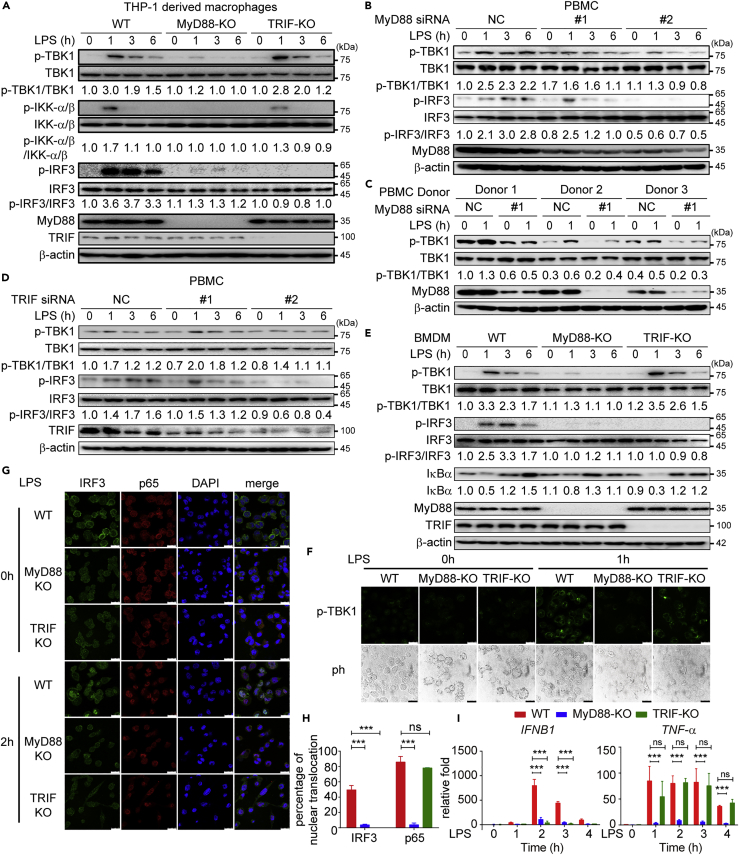
Both MyD88 and TRIF Are Critical for IRF3 Activation by LPS Treatment(A and B) Wild-type (WT), MyD88-knockout (KO), and TRIF-KO THP-1-derived macrophages (A) and peripheral blood mononuclear cells (PBMCs) transfected with or without MyD88 siRNA (B) were stimulated with LPS (200 ng/mL) for indicated time points. Phosphorylation of indicated proteins was detected by immunoblot (IB) analyses.(C) PBMCs from three different donors with or without MyD88 siRNA transfection were stimulated with 200 ng/mL LPS for 1 h or left untreated. Phosphorylation of TBK1 was detected by IB analysis.(D) PBMCs transfected with or without TRIF siRNA were stimulated with LPS (200 ng/mL) for indicated time points. Phosphorylation of indicated proteins was detected by IB analyses.(E) Wild-type (WT), MyD88-knockout (KO), and TRIF-KO bone marrow-derived macrophages (BMDMs) were stimulated with LPS (200 ng/mL) for indicated time points. Protein level of indicated proteins was detected by IB analyses.(F–H) Phosphorylation of TBK1 (F) as well as nuclear translocation of IRF3 and p65 (G) was imaged by confocal microscope and quantified by ImageJ (H); 50 cells were analyzed for each group.(I) Expression of IFN-β and TNF-α was detected by quantitative real-time PCR (qRT-PCR).Data of (A)–(G) are representative of three independent biological experiments; data are shown as mean ± SEM of three independent biological experiments in (H) and (I). ns, not significant (p > 0.05); *** p < 0.001 The magnification of the images is ×400, and the scale bar represents 25 μm.See also Figure S2.